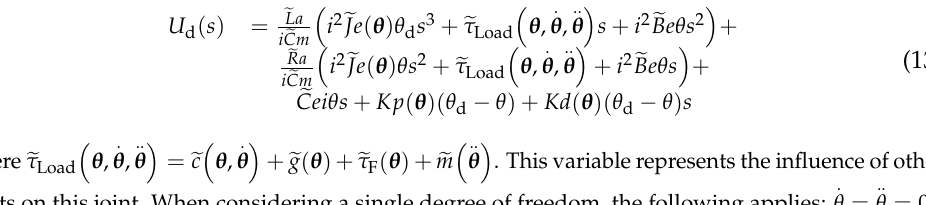
Figure 5. System function block diagram of a single joint.